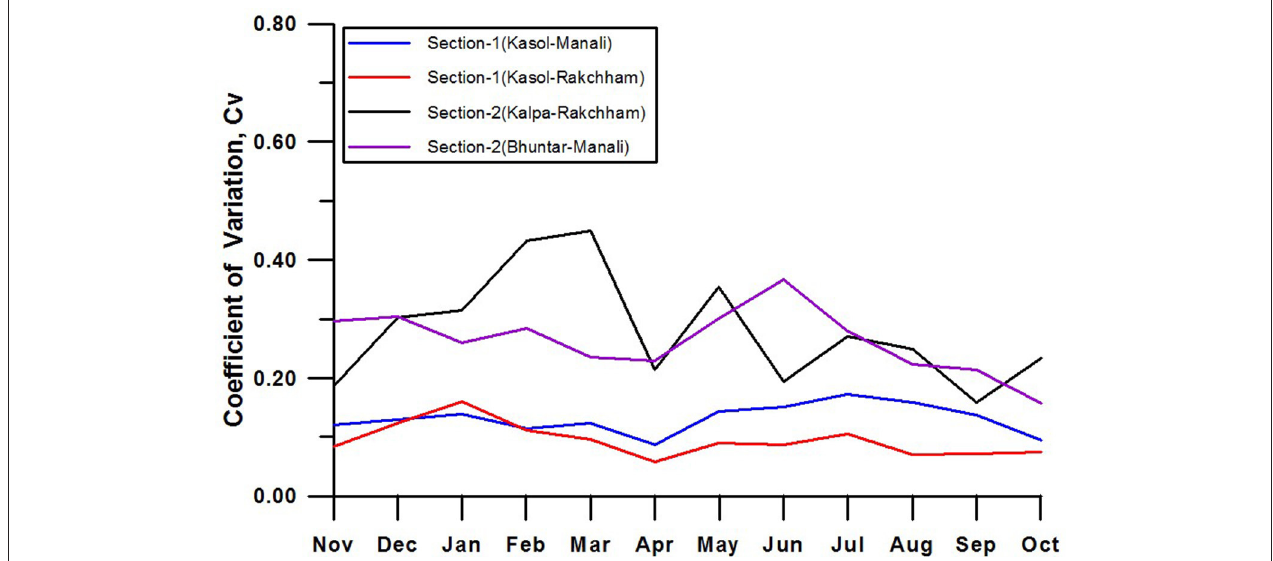
FIGURE 5 | Coefficient of variation (Cv) of section 1 and section 2 of Sutlej and Beas basins showing higher inter-annual stability of valley scale SELR(section 1) as compared to nival–glacier regime SELR (section 2) during 1986–2000/2007 period.